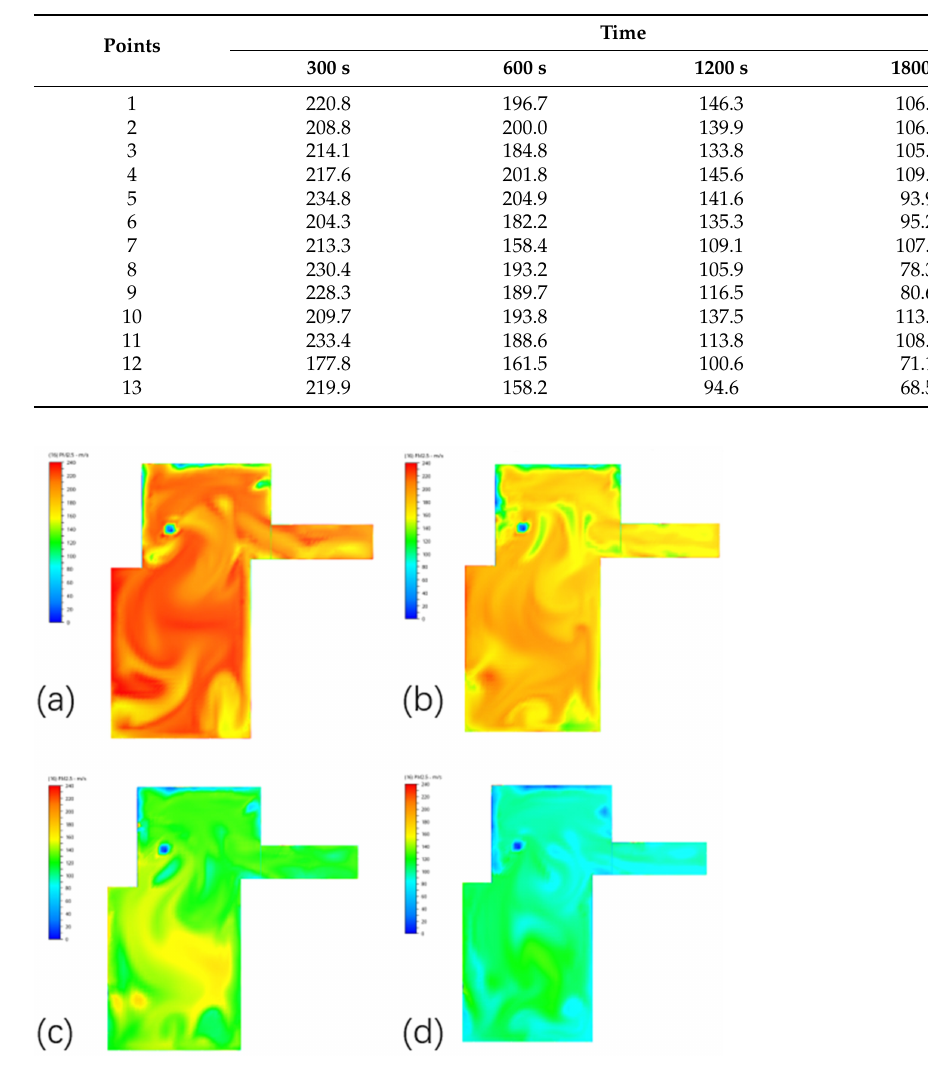
Figure A3. The simulation results of case 3 at the time of ( a ) 300 s; ( b ) 600 s; ( c ) 1200 s; ( d ) 1800